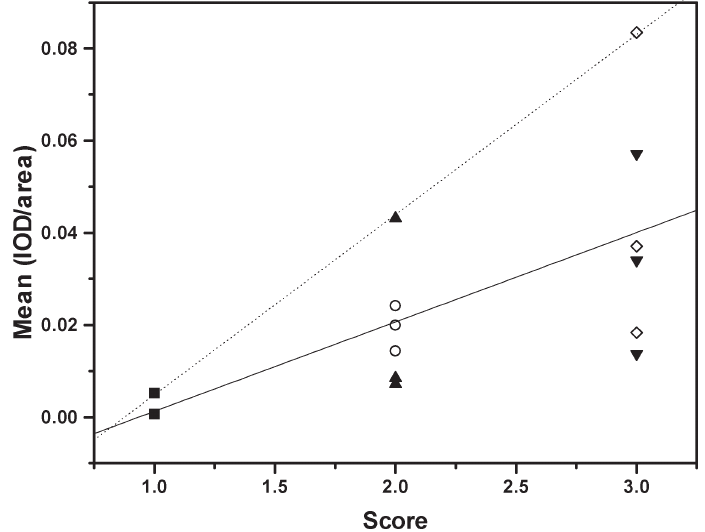
Fig. 5. Relationship between IOD/area and pathologist score for bcl -2 protein expression. Each point represents the mean of approximately 100 cells analysed from a single microscope field. Five slides were analysed, with up to three regions chosen for each. The dashed line is drawn through the highest mean score per slide and a solid line is drawn through the slide